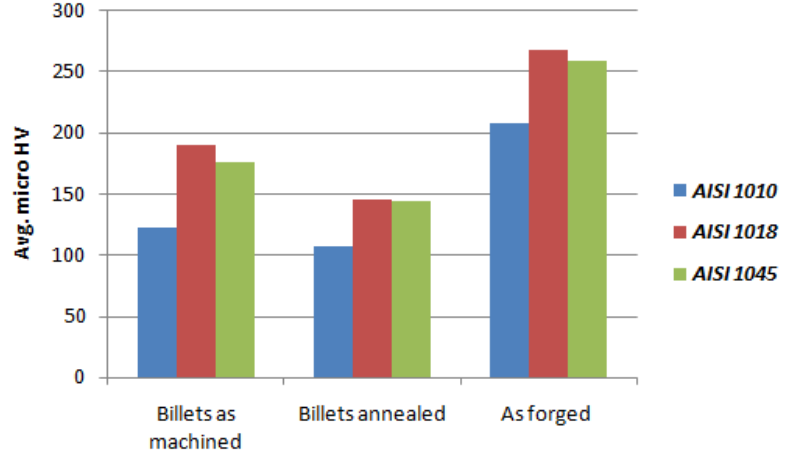
Figure 25. Comparison of micro-hardness values for AISI steels.